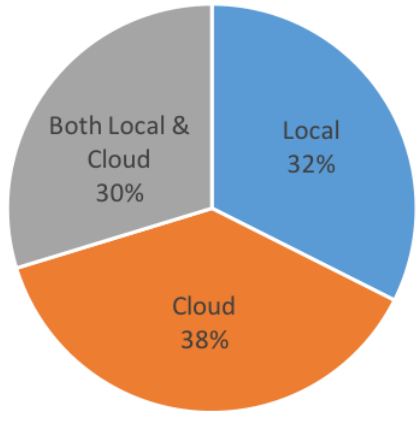
Figure 10. Different storage options for e-monitors.